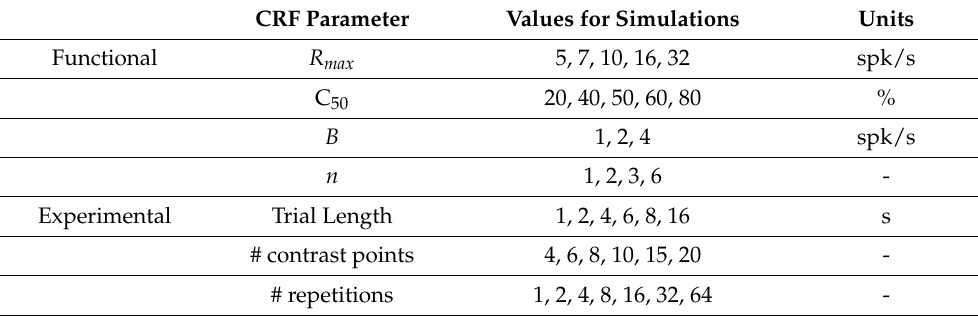
Table 1. Functional and experimental parameter values that were varied in the Monte Carlo simula- tions (all simulations).